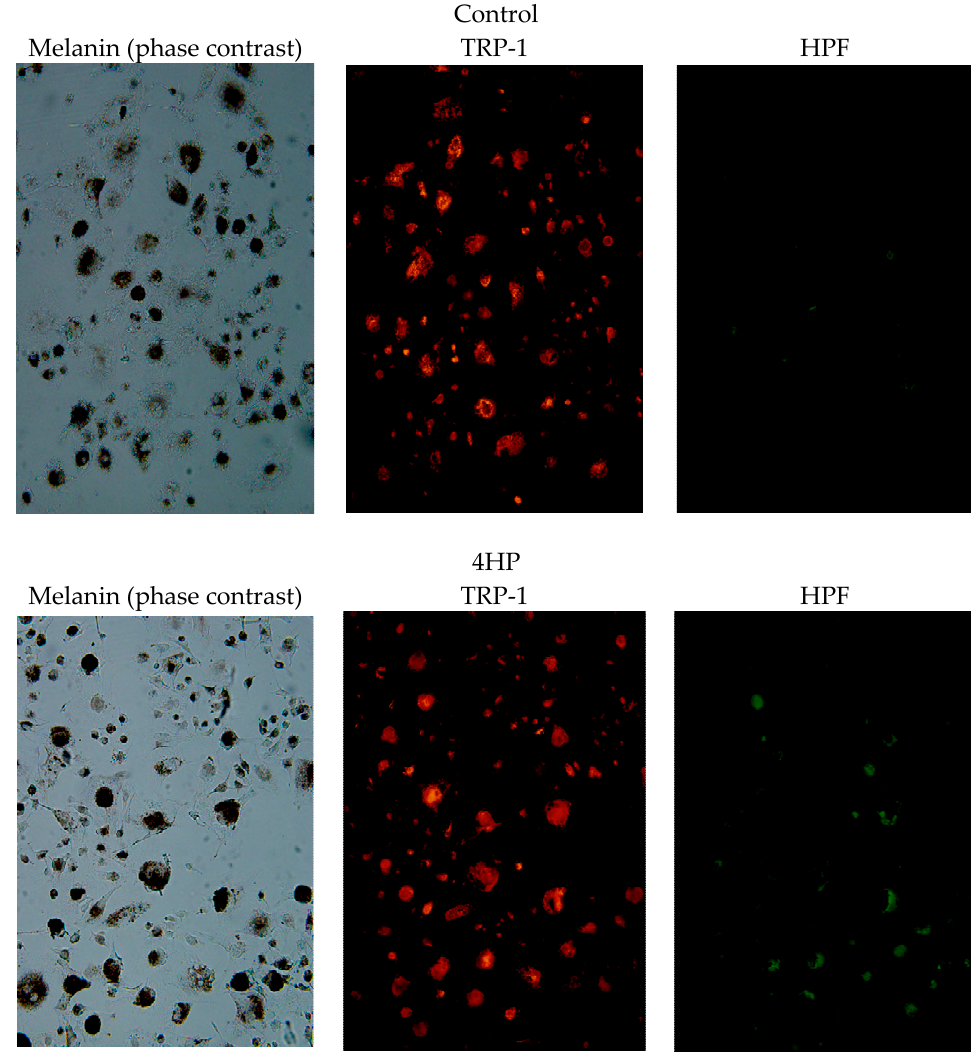
Figure 7. Hydroxy radical ( ∙ OH) generation sites in B16 melanoma cells treated with 4HP. Melanin (phase contrast); Red, anti-TRP-1 antibody-stained melanosomes; Green, fluorescently labeled ∙ OH by HPF. 4HP, rhododendrol; TRP-1, tyrosinase-related protein-1; HPF, hydroxyphenyl fluorescein.